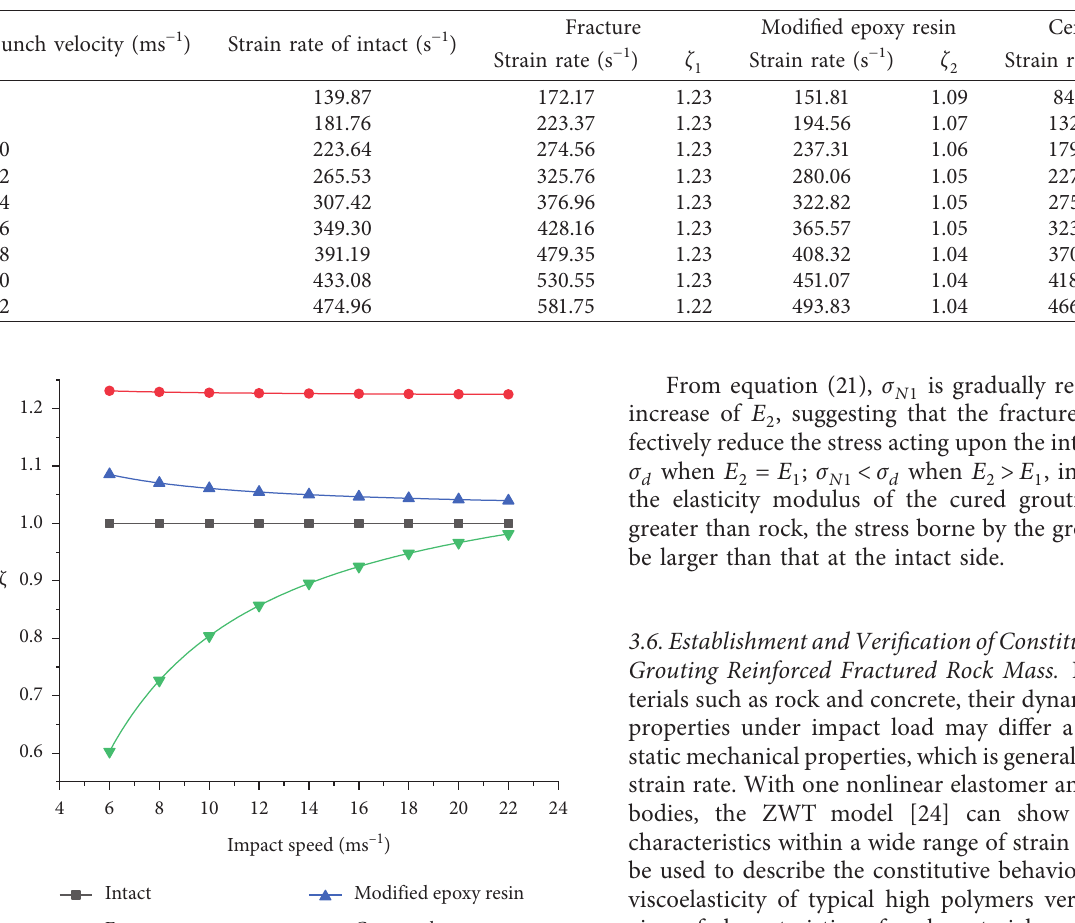
Table 5: Statistical table of specimen strain rate and specific strain rate.